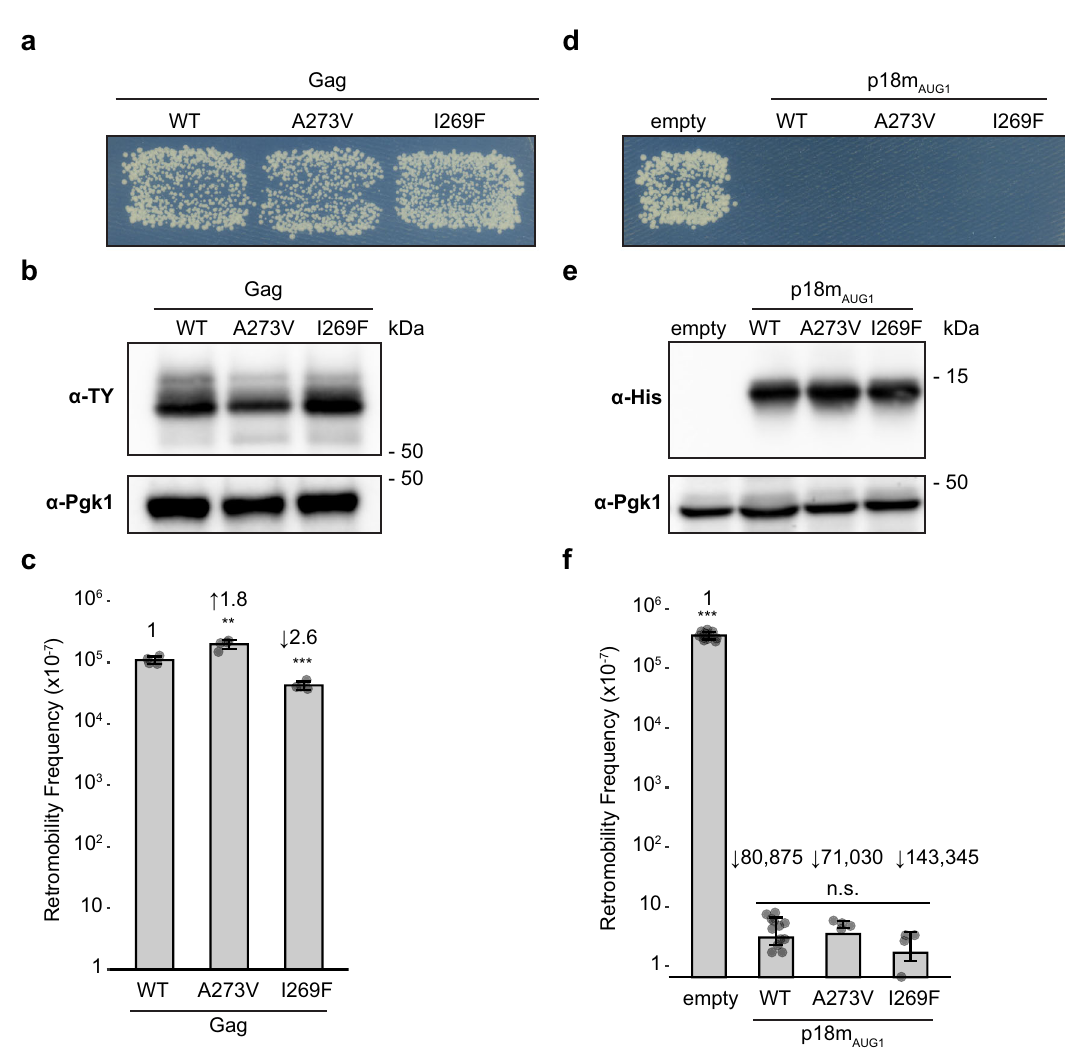
Fig. 4 Ty1 retromobility and restriction tolerates conservative interface mutants. a , d Effect of Gag and p18m AUG1 mutations on Ty1 mobility. Growth on media lacking histidine indicates a retromobility event. A representative image of at least 3 replicates is shown. Gag strains used: WT (DG3735), A273V (DG4342), I269F (DG4341). p18m AUG1 strains used: empty (DG3739), WT (DG4147), A273V (DG4165), I269F (DG4340). b , e Protein extracts prepared from galactose-induced yeast cells expressing the indicated Gag or p18m AUG1 mutants were immunoblotted with TY-tag antibody to detect Gag or hexa- histidine antibody to detect p18m AUG1 . Pgk1 serves as a loading control. Migration of molecular weight standards is shown alongside the immunoblots. A representative image of at least 3 replicates is shown, Images of the whole gel immunoblots are provided in the Source Data fi le. c , f Quantitative mobility assay of galactose-induced cells. Each bar represents the mean of at least four independent measurements displayed as points. The error bar centre represents the mean of the measurements and the error bar extent ± the standard deviation. Fold-change compared with WT is indicated above the bars. Signi fi cance is calculated from a two-sided Student ’ s t -test compared with WT (n.s not signi fi cant, ** p < 0.01, *** p < 0.001. Exact p -values are provided in Supplementary Table 1, See also Supplementary Table 4. Source data is provided in the Source Data fi